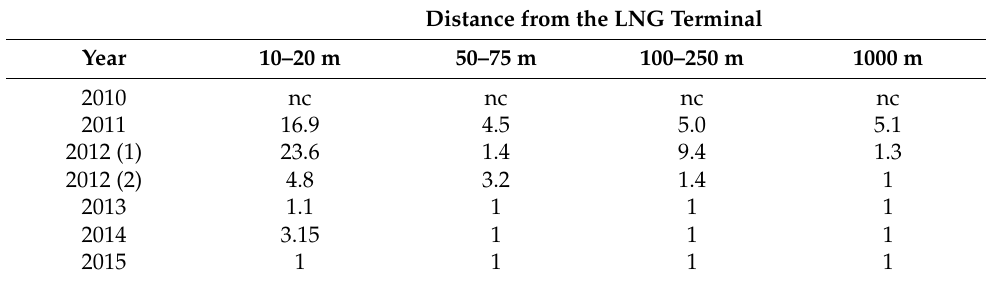
Figure 5. Bromoform concentrations in seawater samples (means ± L-levels) collected from 2010 to 2015 at different sites located away (10–20 m; 50–75 m; 100–250 m; 2000 m; over 5000 m) from the LNG terminal in the Northern Adriatic Sea. (1) July, (2) September. Note: LOQ 0.010 μg/L. Table 1. Seawater concentration ratios (SWCRs) for bromoform resulted during monitoring activities of an LNG terminal in the Northern Adriatic Sea. (1) July, (2) September, nc = not calculated.